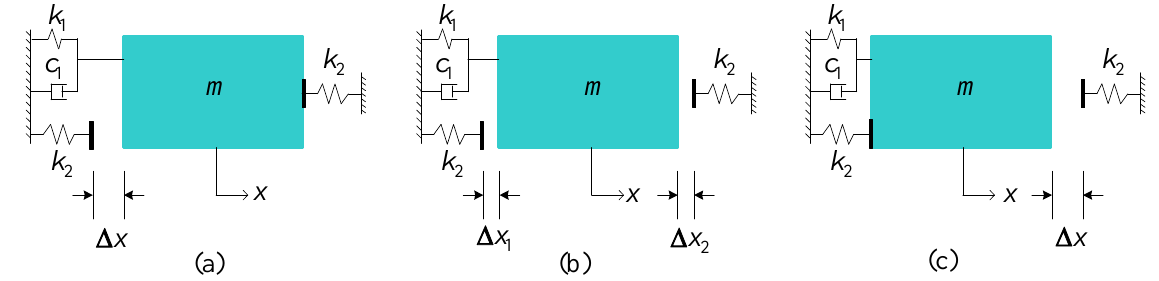
Figure 6. Collision model between the roller bearing seat and the mill housing in the horizontal direction of hot rolling mill rolls. ( a ) The roller bearing seat is pressed against the right mill housing; ( b ) The roller bearing seat is between the mill housing; ( c ) The roller bearing seat is pressed against the left mill housing.